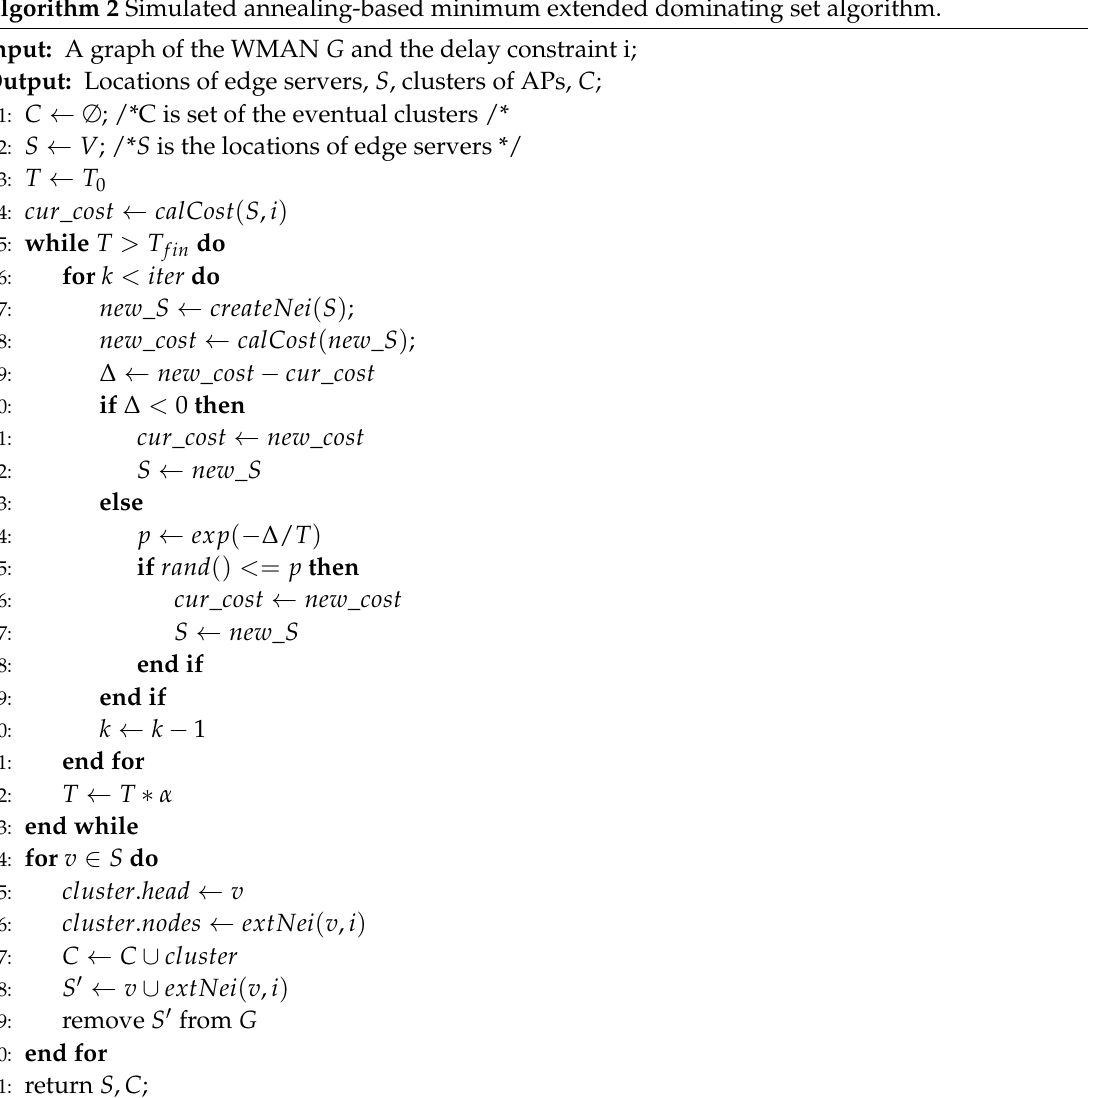
Algorithm 2 Simulated annealing-based minimum extended dominating set